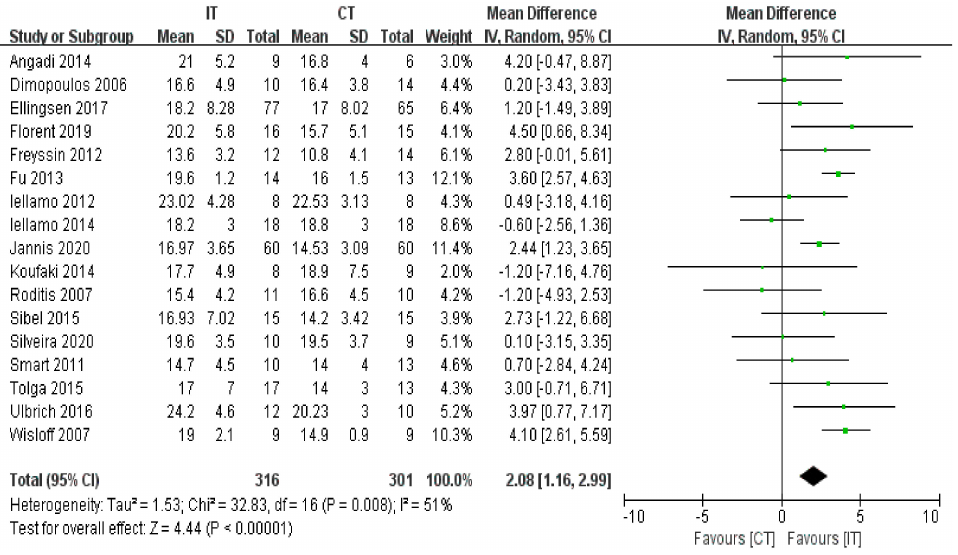
Figure 3. Forest plot: Effects of VO2peak. Table 3. Subgroup analyses of effects of IT vs. CT on VO2peak in HF patients.